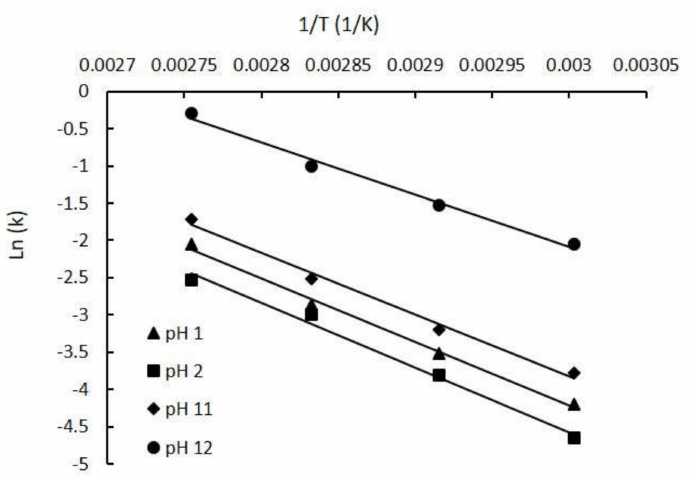
Figure 3. Arrhenius plots for Neu5Ac degradation in aqueous solutions at pH 1.0, 2.0, 11.0 and